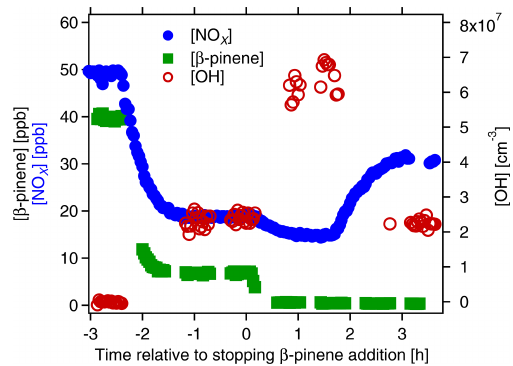
Figure 1. Time series of [ β -pinene] (green squares, left scale), [NO x ] (blue circles, left scale) and [OH] (open brown circles, right scale). The experiment served to estimate the sum of organic ni- trates (ON) formed in a mix of NO x and β -pinene. M -xylene ([ m - xylene] 0 ∼ 3 . 7ppb) was added to the chamber as a tracer for OH. At time t = − 2 . 4h OH formation was induced by O 3 photolysis. At time t = 0h, β -pinene addition was stopped, and at time t = 1 . 7h J(O 1 D) was reduced to obtain the same [OH] as in the presence of β -pinene at time −